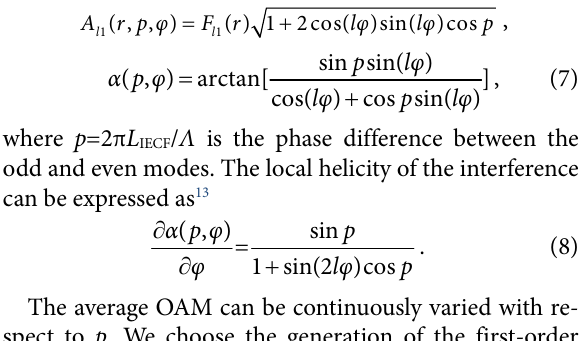
Fig. 4 | Evolution diagrams of intensity and phase from the LP MSCs and those from the c LP IECFs with different splicing angles of 45°, 22.5°, and 15° 34 .